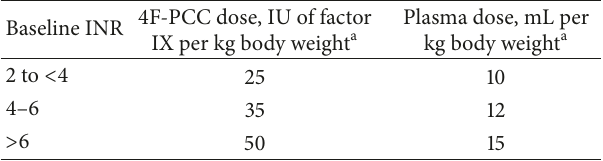
Table 1: Dose of study treatment per baseline